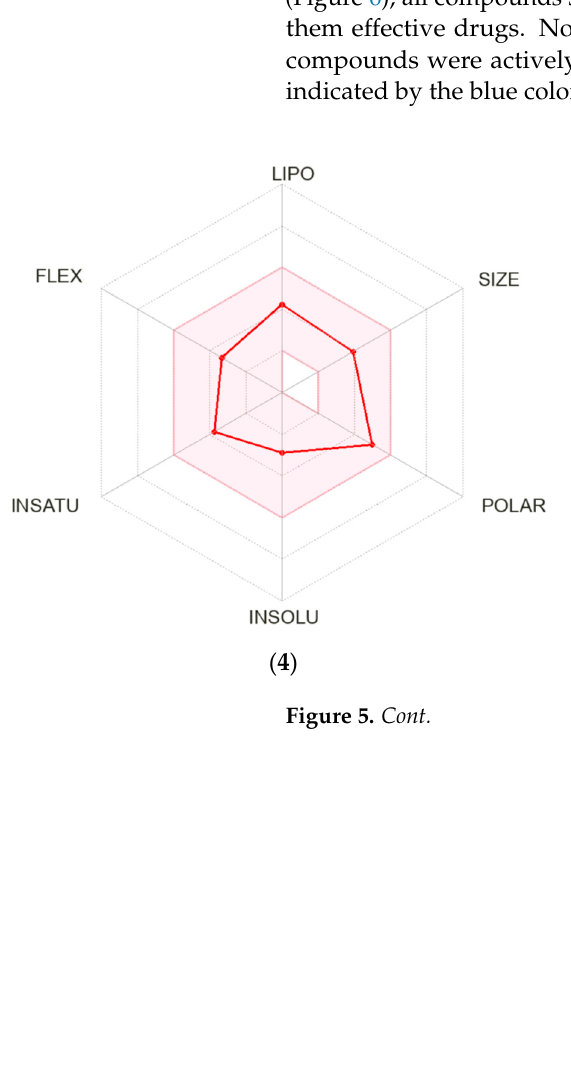
Figure 4. Intermolecular hydrogen bonds in 4 – 9 .